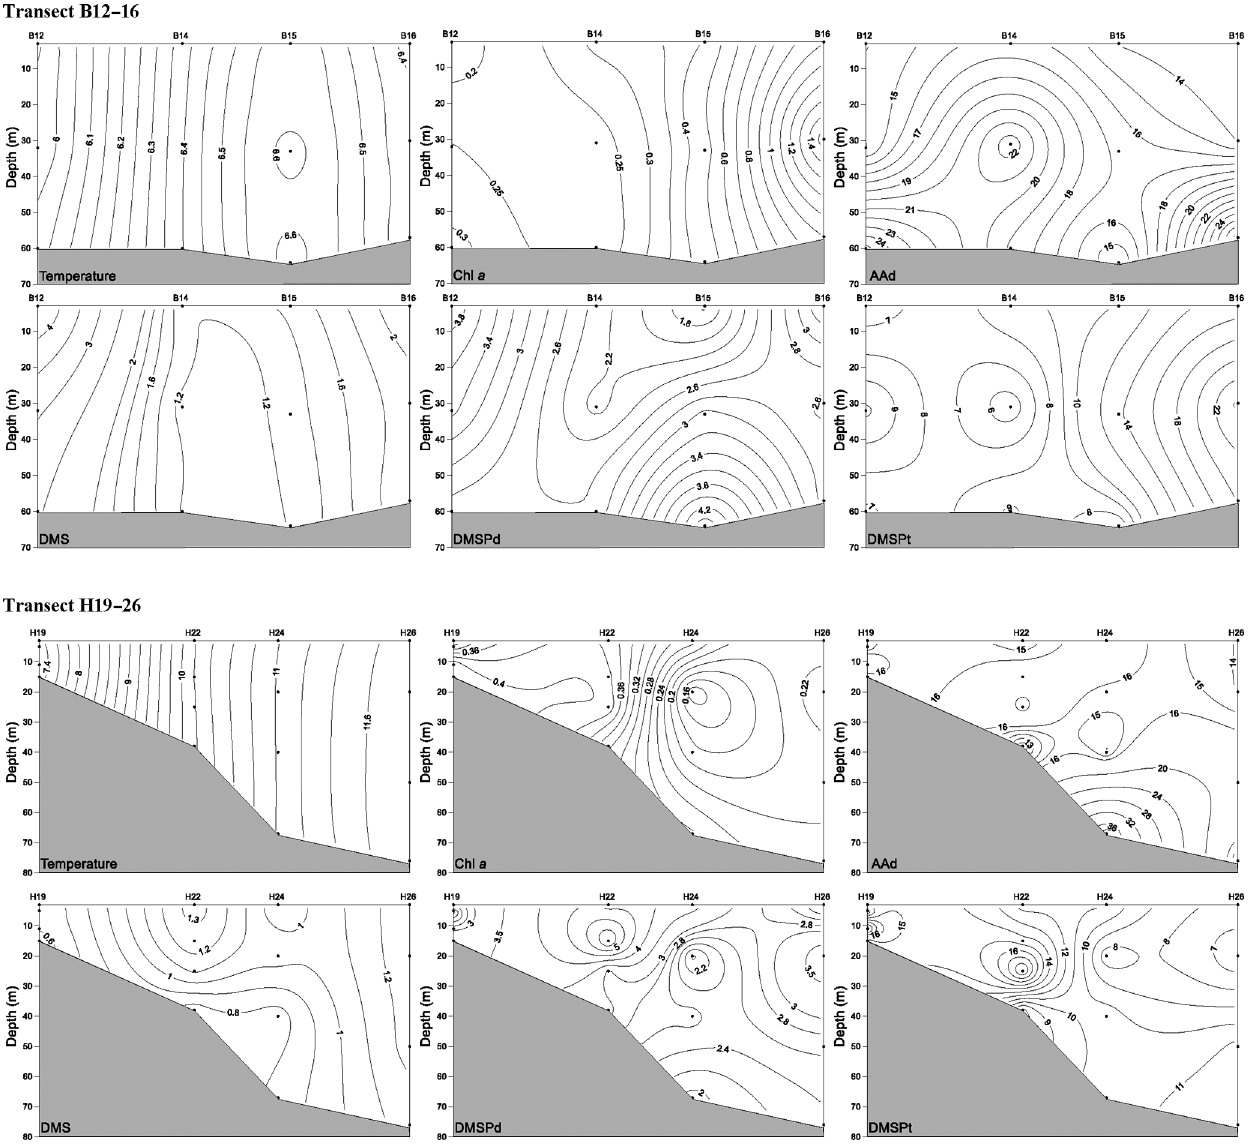
Figure 5. Vertical profiles of temperature ( ◦ C), Chl a (µgL − 1 ), AAd (nmolL − 1 ), DMS (nmolL − 1 ), DMSPd (nmolL − 1 ), and DMSPt (nmolL − 1 ) along transect B12–16 and transect H19–26 during winter. A kriging method is used for interpolating contours. The black dots represent sampling